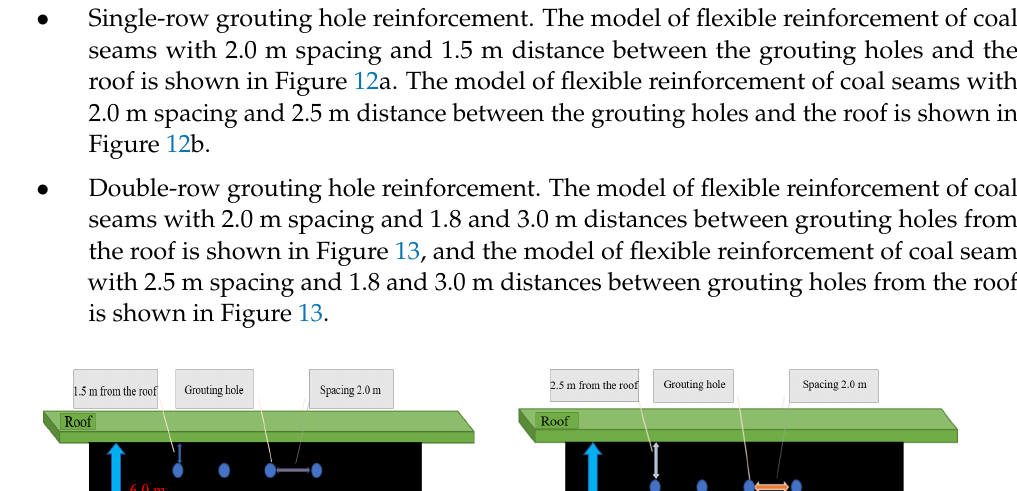
Figure 12. Reinforcement model of single-row grouting pipe: ( a ) 1.5 m from the roof; ( b ) 2.5 m from the roof.